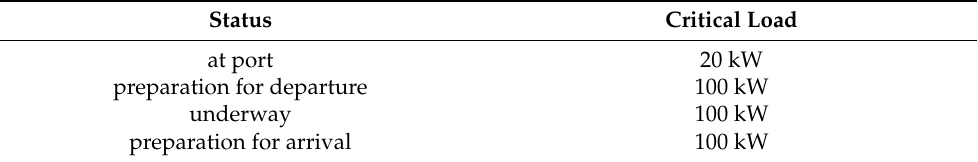
Table 4. Critical load approximation.